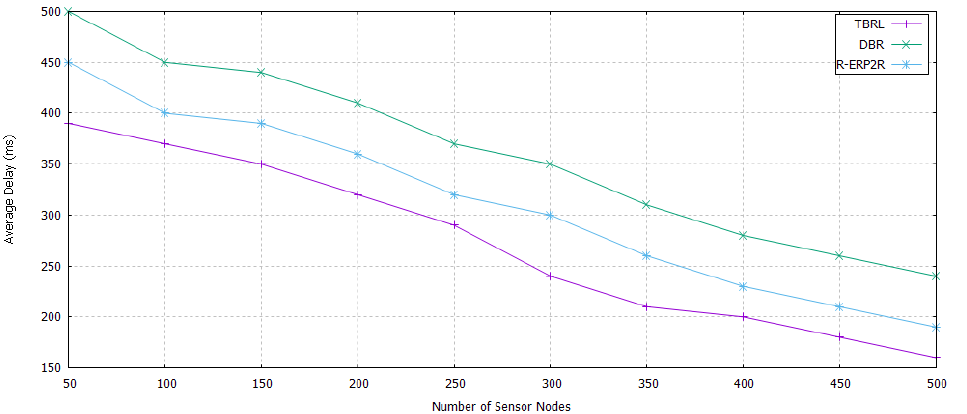
Figure 13. End to End Delay of TBRL, Depth Based Routing (DBR), and Reliable Energy-efficient Routing Protocol (R-ER P 2 R).